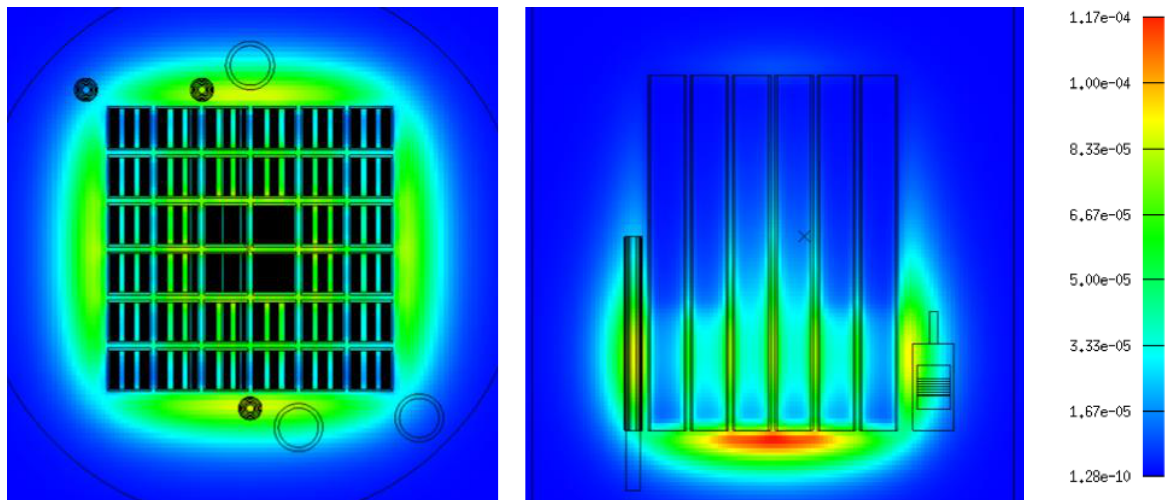
Figure 3 – Thermal flux distribution given with source neutron normalized to 1 n/s at critical state xy plane (left) and xz